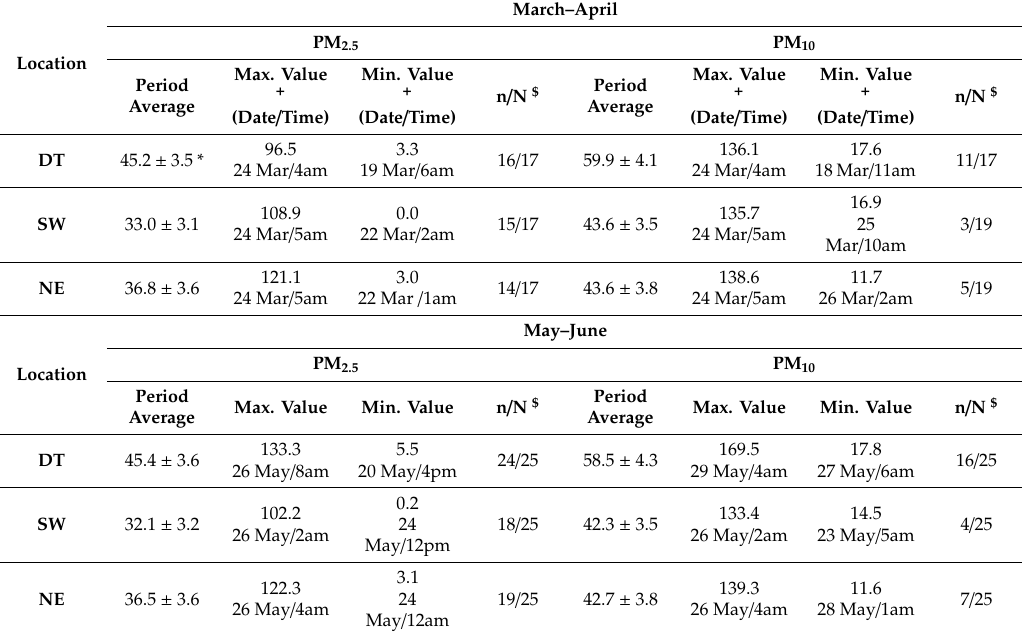
Table 1. Average, maximum, and minimum PM values (in µ g / m 3 ) in the three sampling locations, during the two sampling